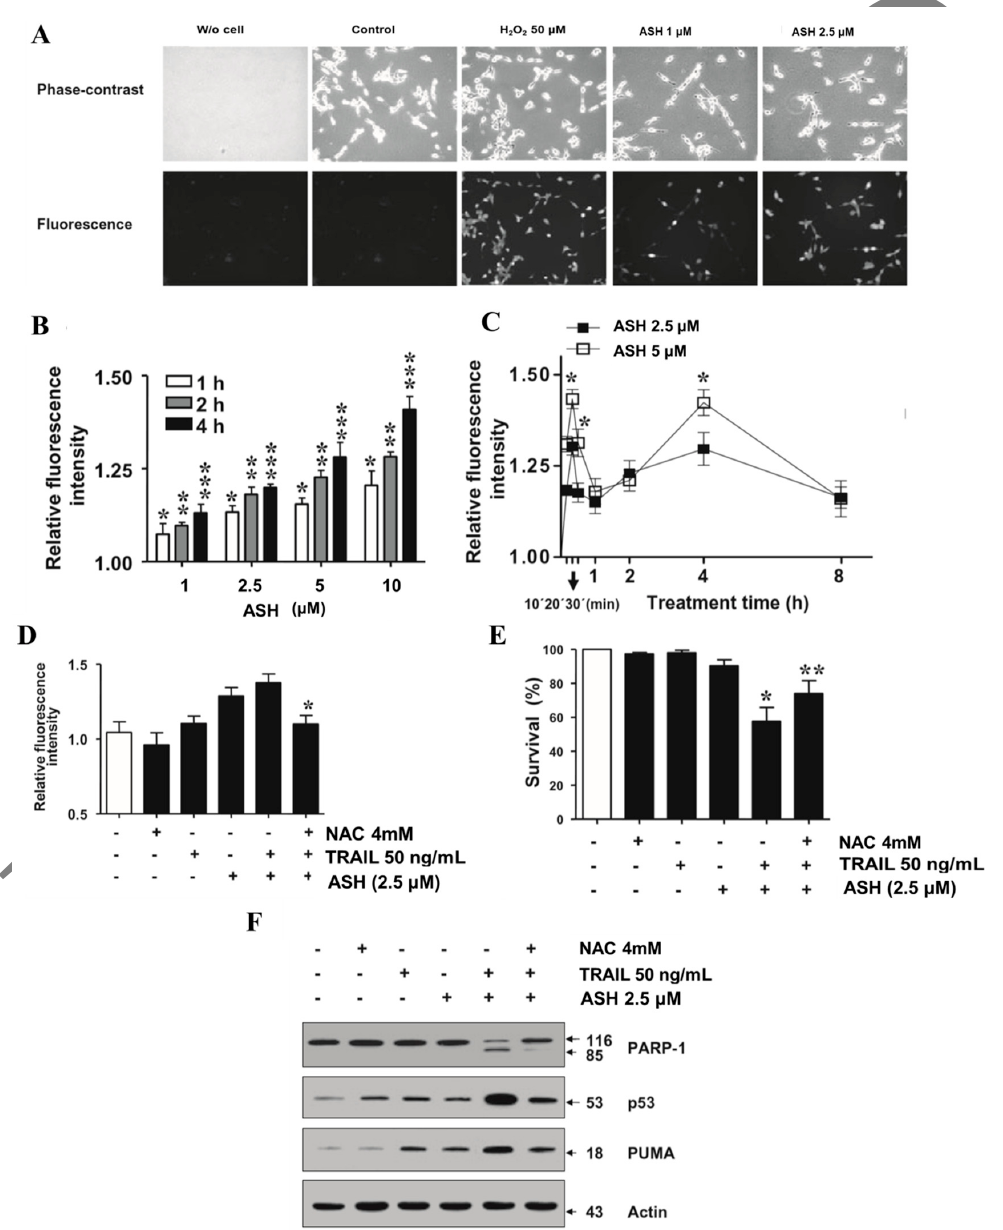
Figure 4. ASH-induced ROS production in a HepG2 cell. ( A ) ROS production in HepG2 cells was analyzed by fluorescence microscopy. Cells were treated with H2O2 (positive control) or ASH (1, 2.5 μ M) for 60 min and labeled with CMH2DCFDA (20 μ M/L) for 20 min. The positive control group or ASH (2.5, 5 μ M) group showed significant higher fluorescence intensity as compared to the vehicle (PBS + 0.01% BSA) control group. ( B ) After exposure with ASH (2.5, 5 μ M) for various times, the intracellular ROS production in HepG2 cells was analyzed by the relative fluorescence intensity. * p < 0.05; ** p < 0.01; *** p < 0.001 ( C ) HepG2 cells were labeled with CMH2DCFDA after treating with ASH (2.5, 5 μ M) for different times. ROS productions at different time-points were quantified by the relative fluorescence intensity using the fluorescence plate reader. * p < 0.05 ( D ) Pretreated with N-acetyl-l-cysteine (NAC) (ROS inhibitor) significantly decreased the ROS level induced by ASH (25 μ M), and ( E ) reversed ASH- and TRAIL-mediated HepG2 cell death. * obvious changes between ASH and TRAIL + ASH group ( p < 0.05). ** Obvious changes between NAC+ TRAIL + ASH group and TRAIL + ASH group ( p < 0.01). Control group received an equal amount of vehicle (PBS + 0.01% BSA + 0.1% DMSO).